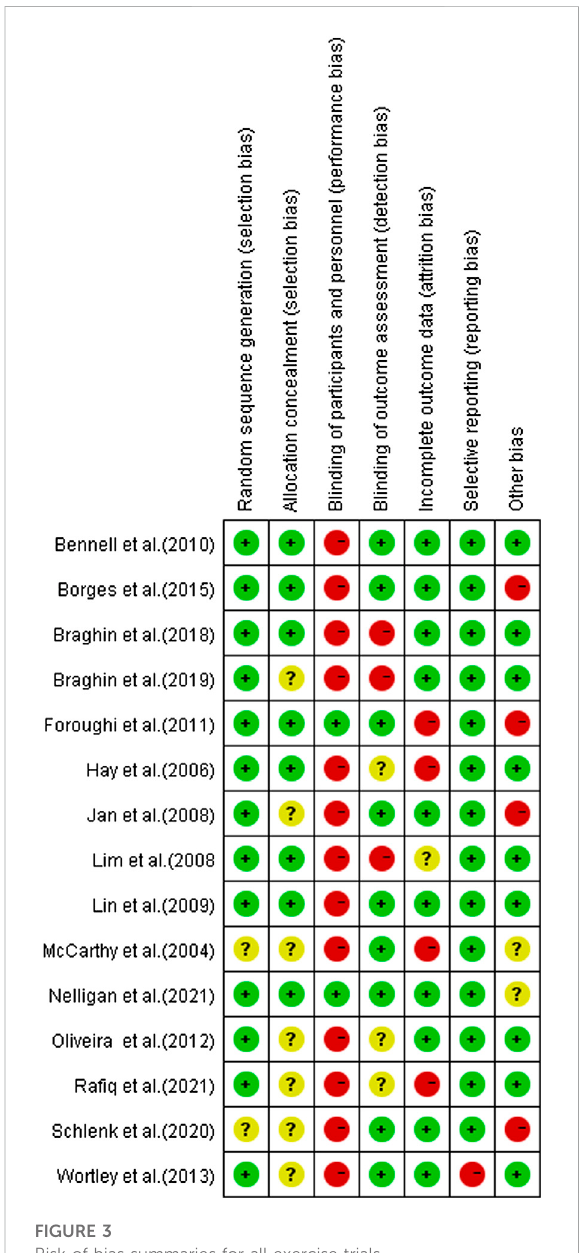
FIGURE 3 Risk of bias summaries for all exercise